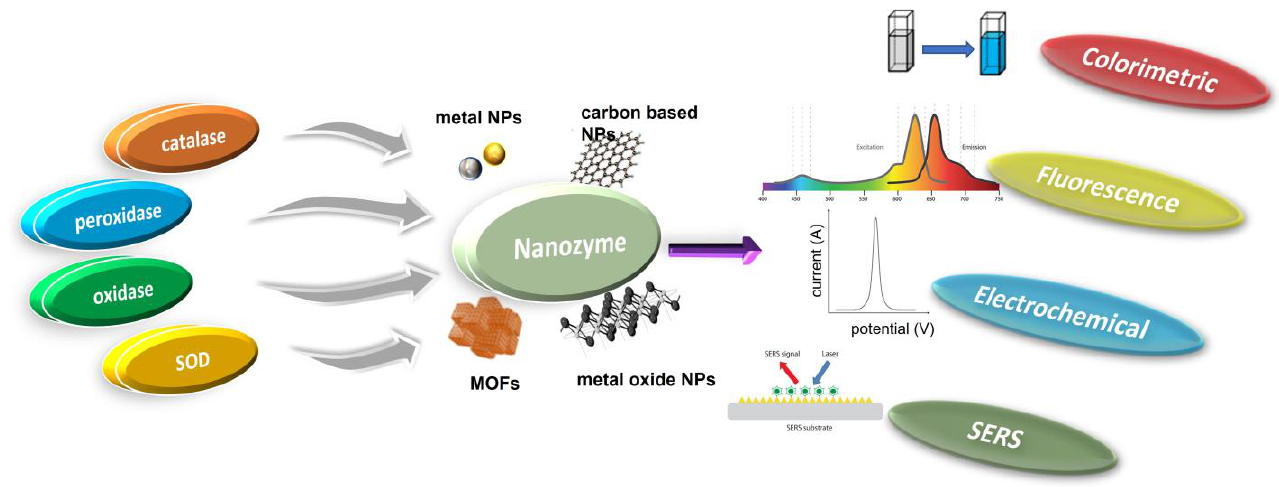
Figure 1. Schematic illustration of various mimicking types of enzymes and the nanozyme base.